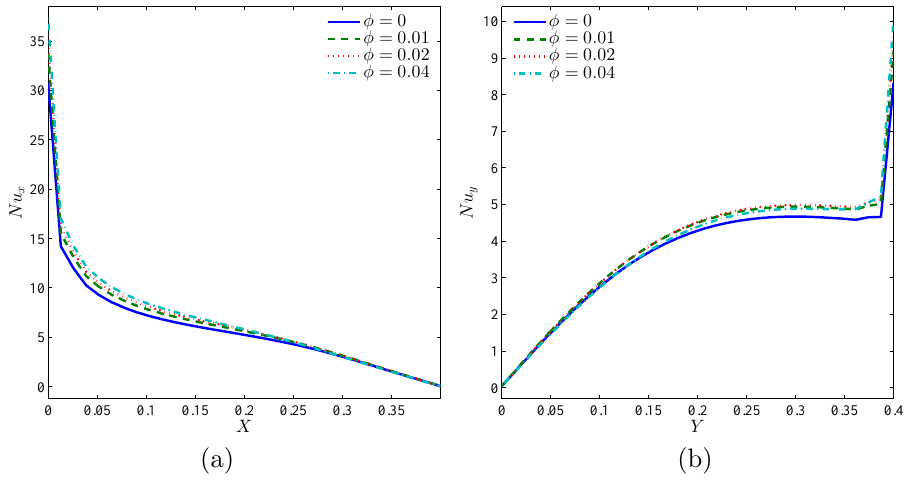
Figure 11. Variations of the local Nusselt numbers along ( a ) the bottom side wall ( X ) and ( b ) the left side wall ( Y ) for different φ at Ra = 10 5 , k w = 0.76 and D =